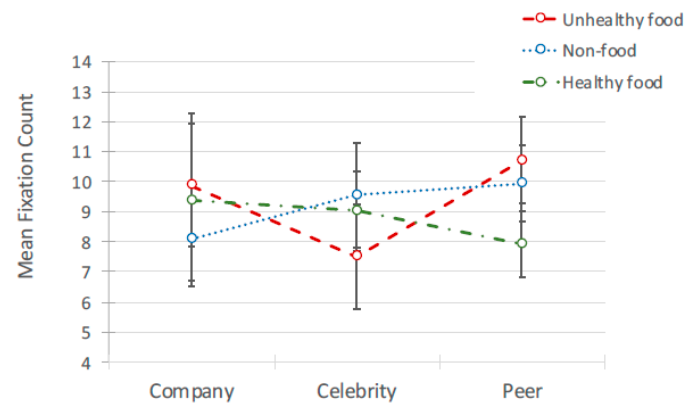
Figure 12. Interaction between fixation count and source of ad for 3 types of ad.